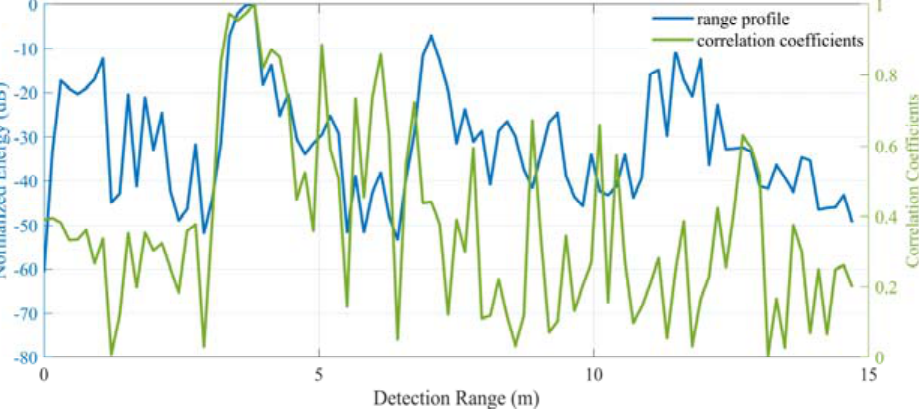
Figure 12. Comparison result processed by the method in [34] of the experiment with multiple targets, where the blue line represents 1D range profile used for detection and the green line represents the normalized correlation.